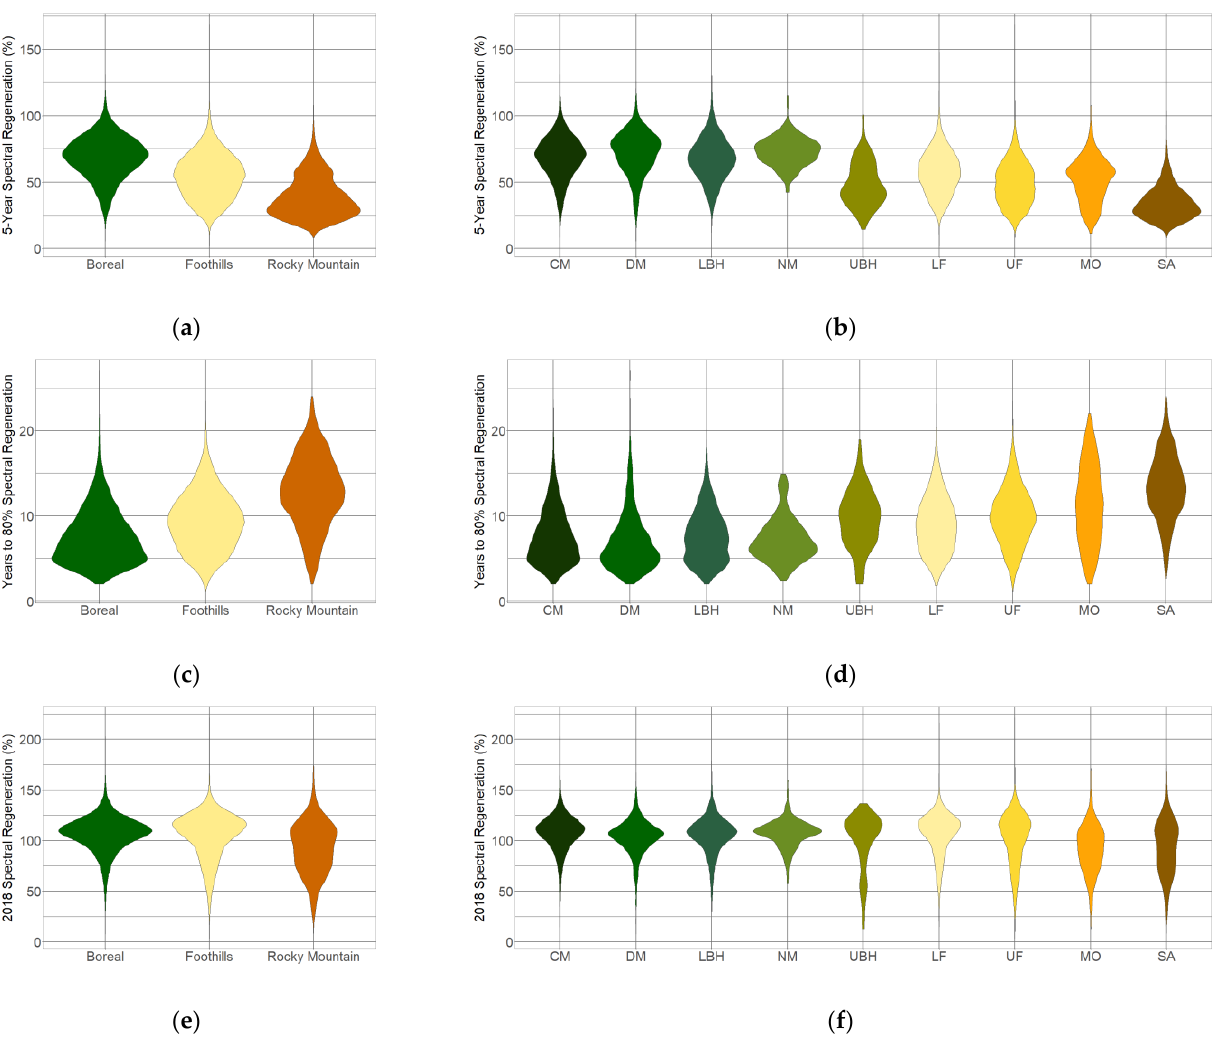
Figure 8. Violin plots showing the distributions by Natural Region ( a , c , e ) and Natural Subregion ( b , d , f ) for Recov% 5yr ( a , b ), Y2R ( c , d ), and Recov% endTS ( e , f ). See Figure 7 for Subregion abbreviation definitions.